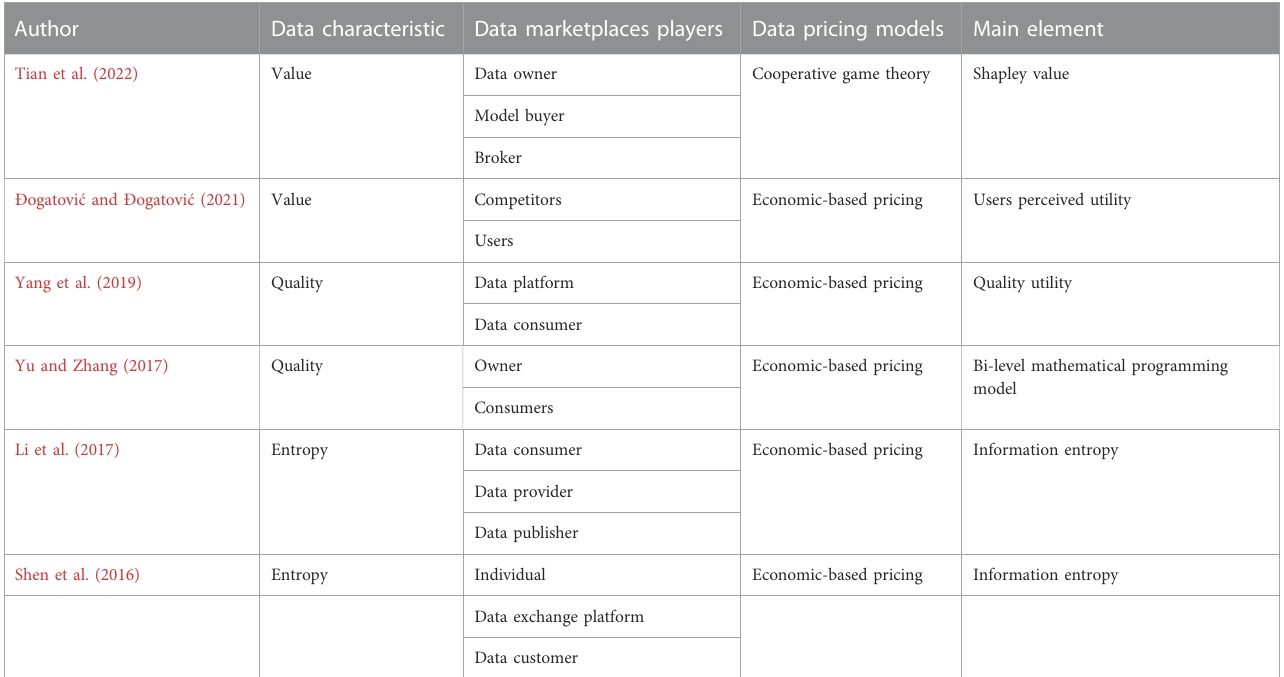
TABLE 3 Data pricing